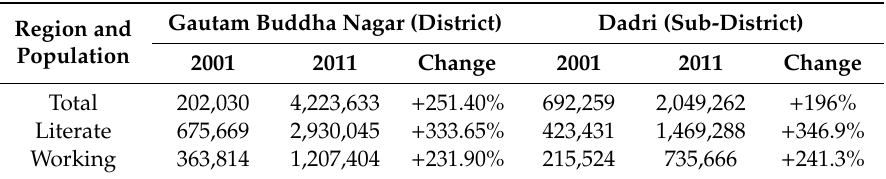
Table 1. Census data of Gautam Buddha Nagar and Dadri sub-district.( Courtesy: Ministry of Statistics and Programme Implementation, Government of India